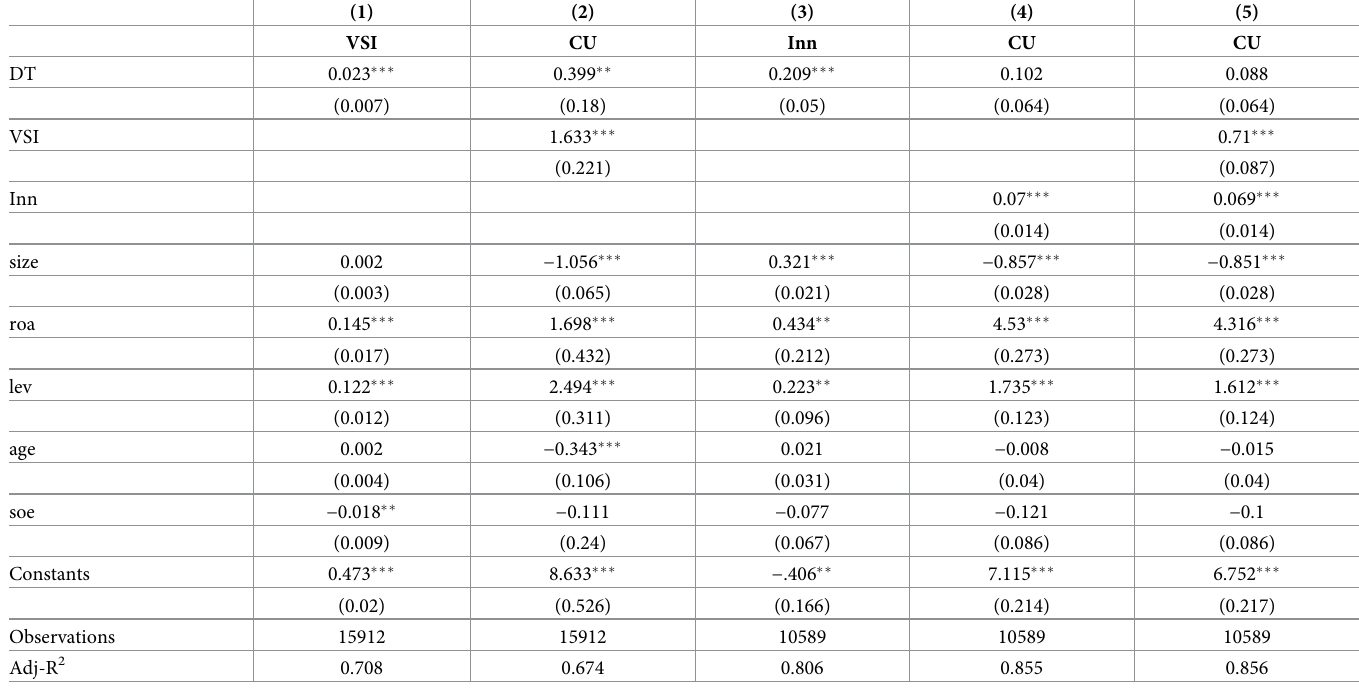
Table 5. Heterogeneity analysis